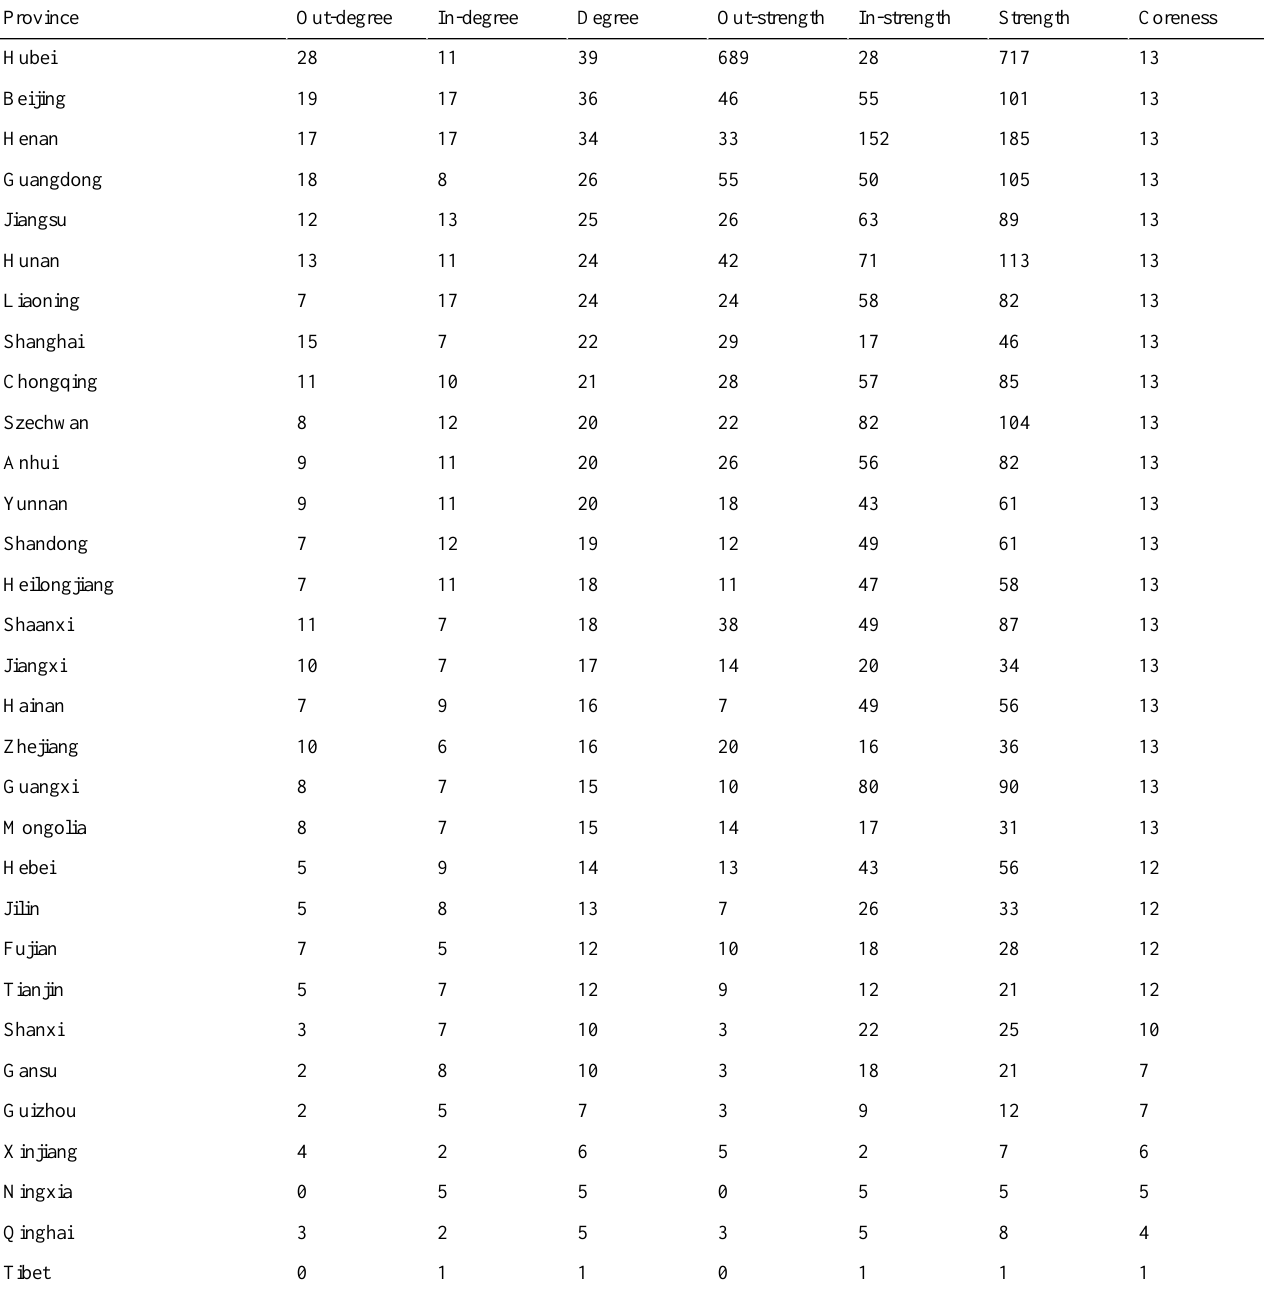
Table 3. Central properties of 31 provinces during the COVID-19 epidemic. The provinces are arranged in descending order according to the indicators of coreness and